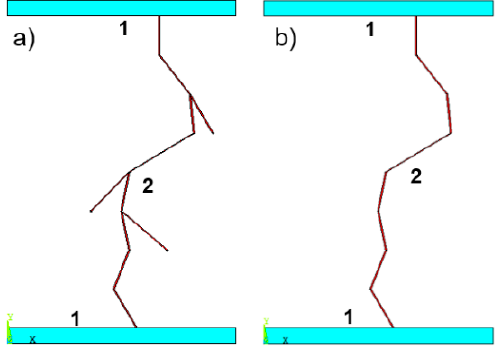
Figure 14. The geometry of the discharge obtained on the basis of streamers propagation analysis ( a ) and adopted for the analysis of the breakdown stage ( b ). 1—electrodes; 2—discharge.